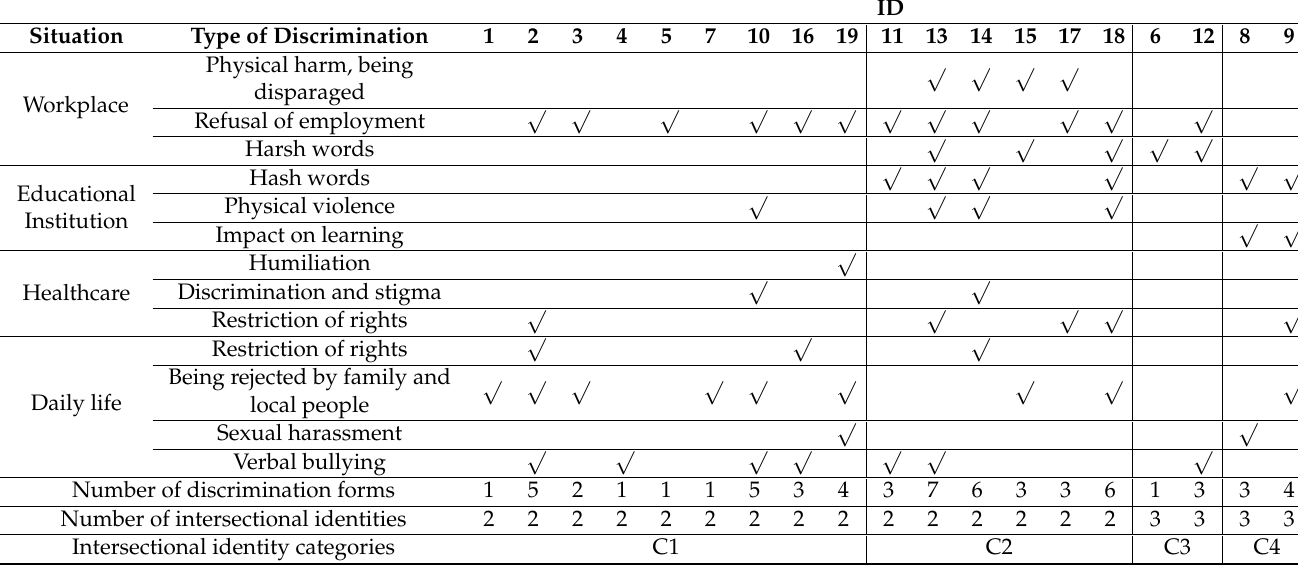
Table 2. Intersectional identities and multiple discriminatory